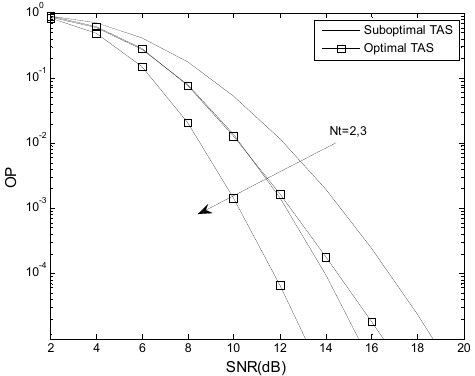
Figure 8. The OP performance of the optimal and suboptimal TAS schemes for different numbers of antennas N t .